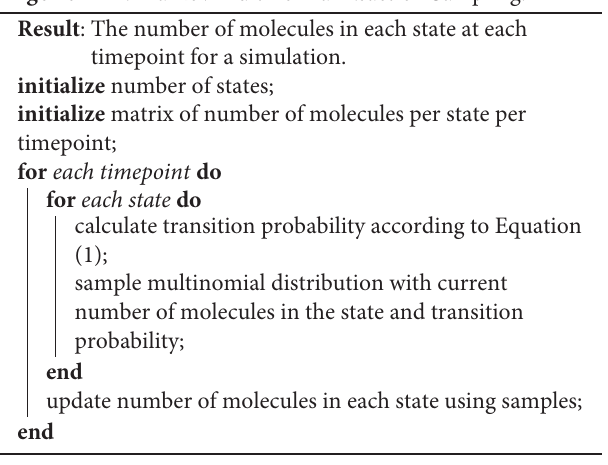
Algorithm 1: Markov Multinomial Reaction